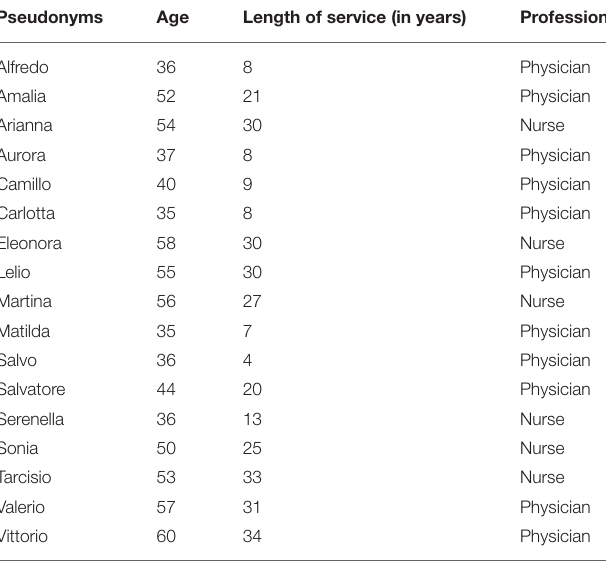
TABLE 2 | Participants: physicians and